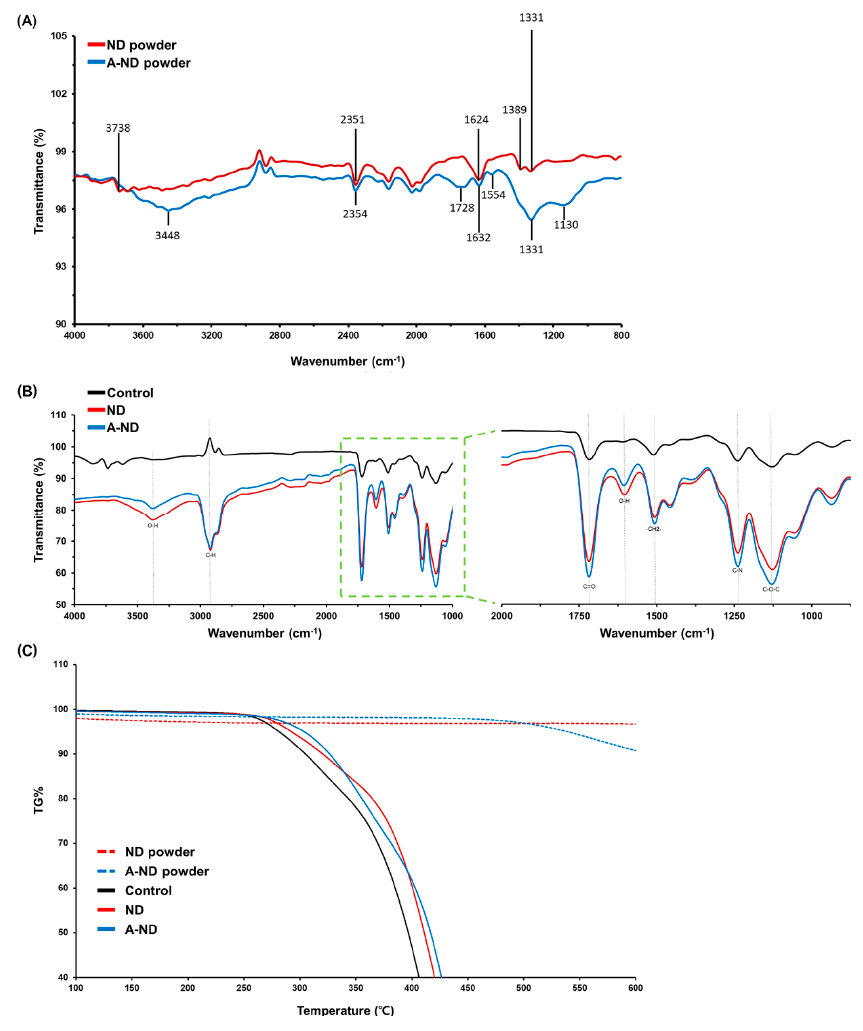
Figure 3. ( A ) FT-IR spectra of the ND and A-ND powders; ( B ) the control, ND- and A-ND-